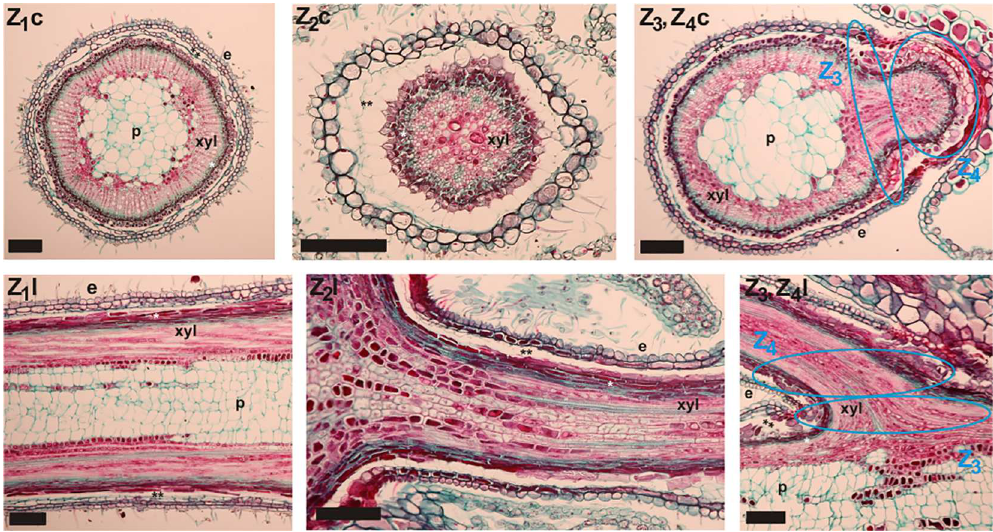
Fig 3. Imagesof cross (c) and longitudinal(l) sections of the vegetativeshoot(Z1),of the upperpartof the pedicel(Z2),of the transitionzone betweenvegetative and reproductive shootand basalpartof the reproductive shoot(Z3,Z4) of C. vulgaris aftertriplestainingwithSafranin,OrangeG, and Fast Green. Pith (p),xylem (xyl),phloem(singlewhite asterisk), parenchym (double black asterisk), and epidermis (e) tissue are indicatedin the sections. Horizontalblack bar = 0.1